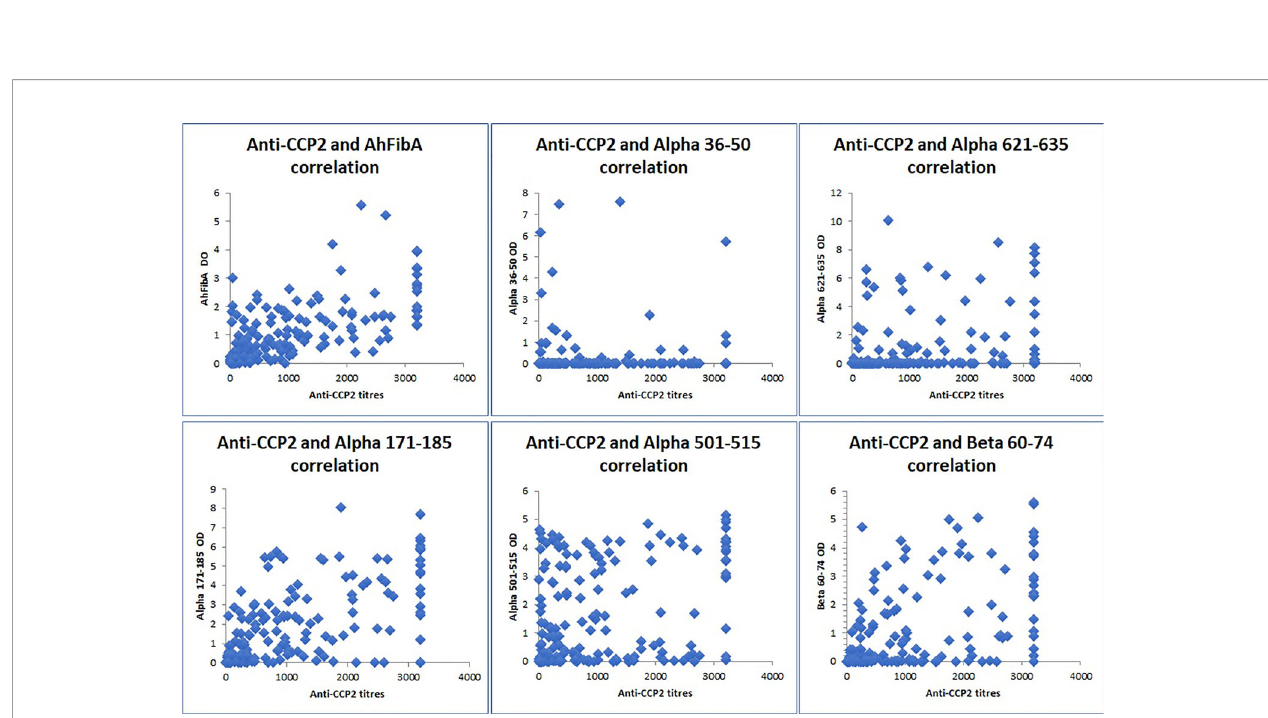
FIGURE 1 | Different pro fi les of epitopic reactivity in the cohort of 184 patients.